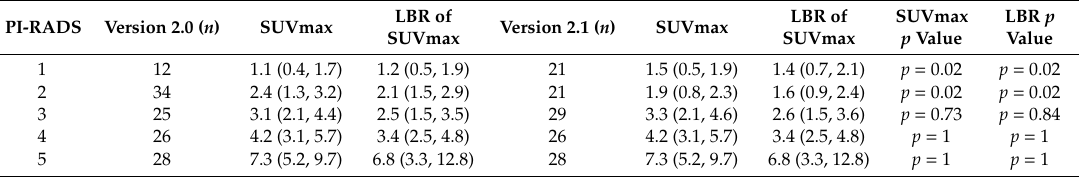
Table 2. TZ lesions SUVmax and corresponding LBR of SUVmax for Version 2.0 and 2.1. PI-RADS Version 2.0 ( n )